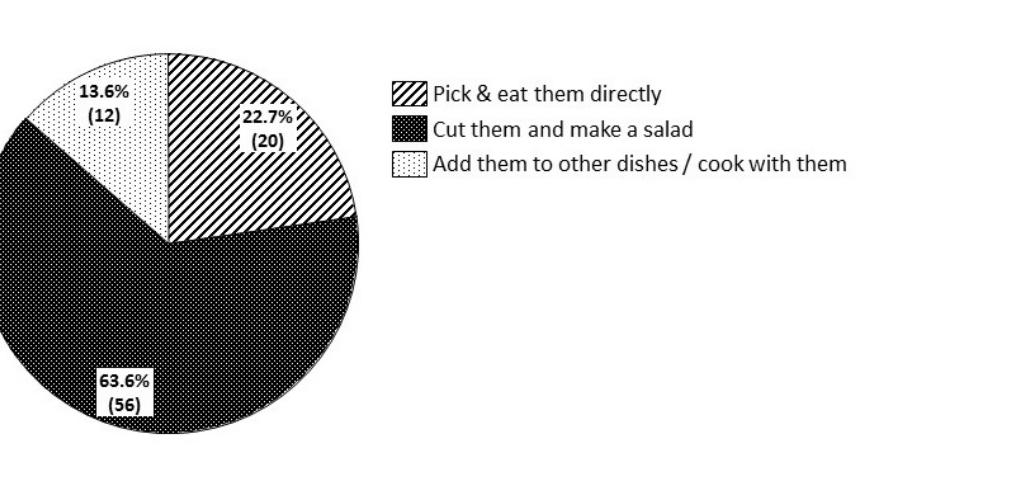
Figure 9: The 85% of respondents indicating that the availability of fresh fruit, vegetables and herbs grown on the Neumayer Station (85%, 88 individuals) would improve their overall well-being were asked the question ‘What would you do with the selected vegetables and herbs’ and to choose one of the indicated